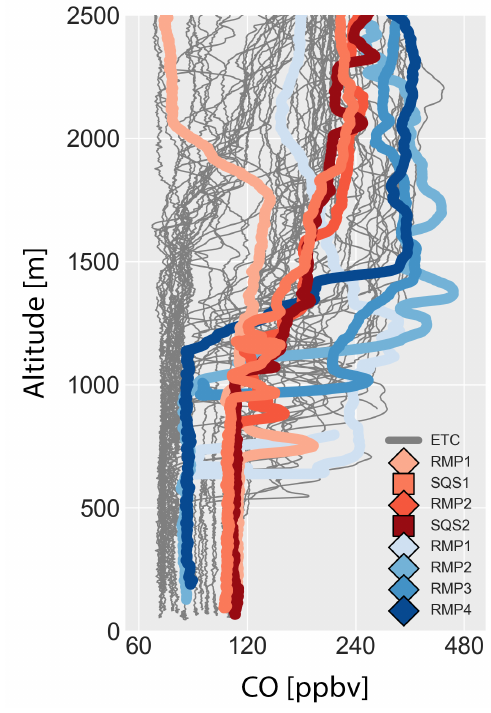
Figure 6. Vertical profiles of observed CO for all ORACLES-2016 flights (grey lines), with the profiles from 31 August and 4 Septem- ber highlighted in shades of red and blue,